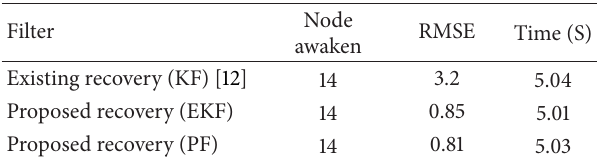
Table 2: Performance comparison: node failure—Case II.